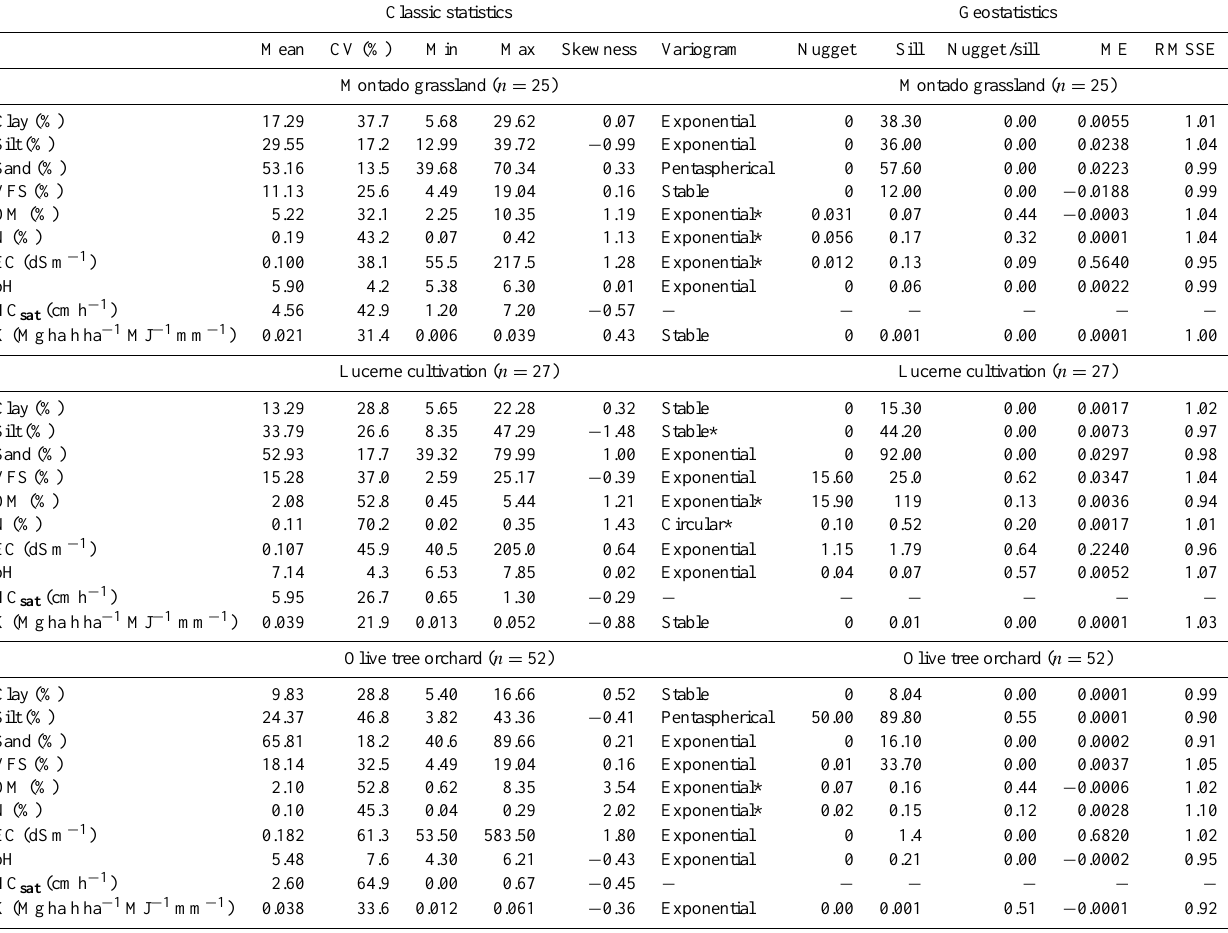
Table 1. Descriptive statistics of soil properties and parameters of the fitted variogram models and the cross-validation results. Classic statistics Geostatistics Mean CV (%) Max Skewness Variogram Nugget Sill Nugget /sill RMSSE Montado grassland ( n = 25) Montado grassland ( n = 25) Clay (%)